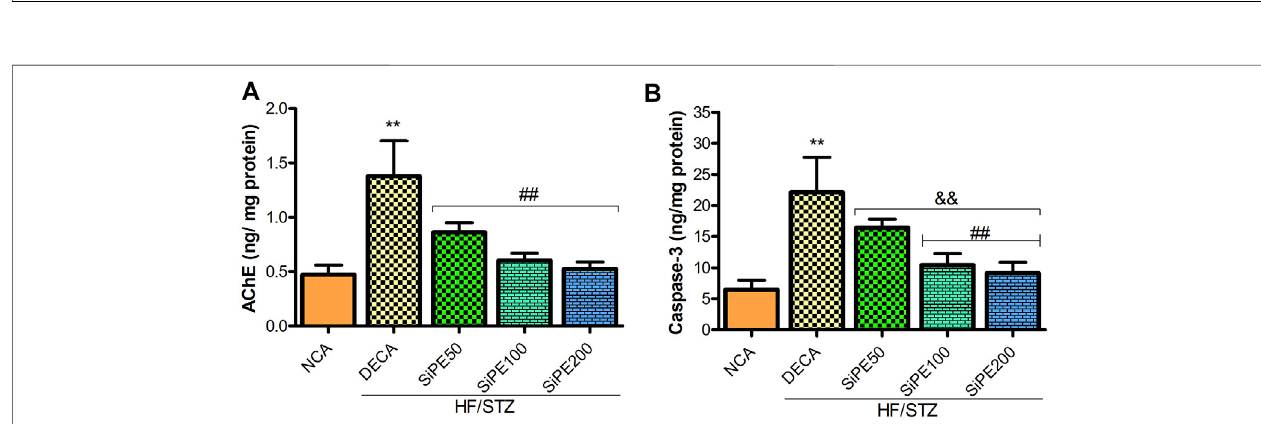
FIGURE 8 | Effect of SiPE treatment on biochemical parameters in HF/STZ-induced diabetic encephalopathic rats. SiPE treatment at doses of 50, 100 or 200 mg/kgcausedsigni fi cantreductionin (A) acetylcholinesterase(AChE)and (B) caspase-3levelscomparedtoDECAgroup.Dataarepresentedasmean ± SD( n (cid:2) 6) andone-wayANOVAtestwasapplied.** p < 0.001indicatesstatisticalsigni fi cancecomparedtoNCAgroup.## p < 0.001,&& p < 0.01and$$ p < 0.05indicatestatistical signi fi cance compared to DECA group.